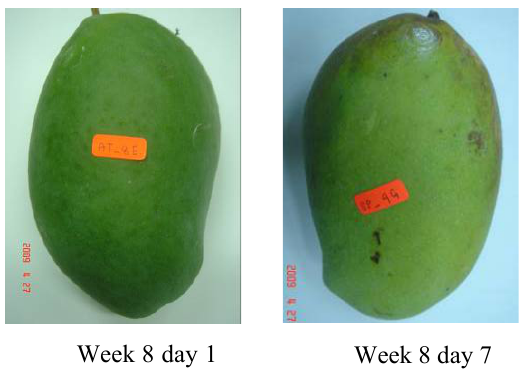
Figure 1. The skin colour of two different maturity stages, week 8 day 1 and week 8 day